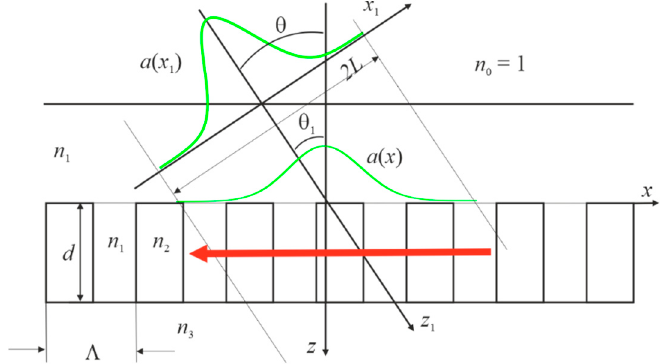
Figure 1. Incidence of the Gaussian beam on the grating with the following parameters: Λ = 0.697748 µ m, n = 1.333, n = 2, n = 1.45, F = 0.5. Angle θ is 0 or π /18 according to numerical analysis. Wavelength λ and grating thickness d are constant.